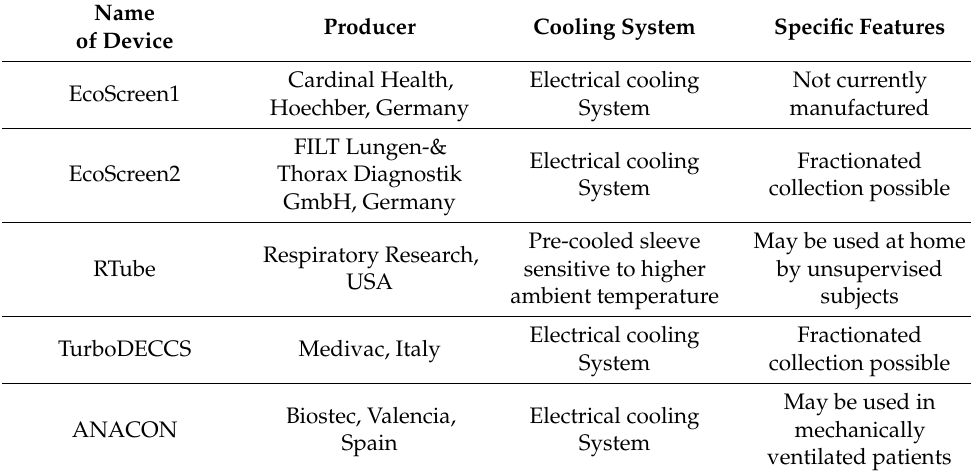
Table 1. Types of condensing